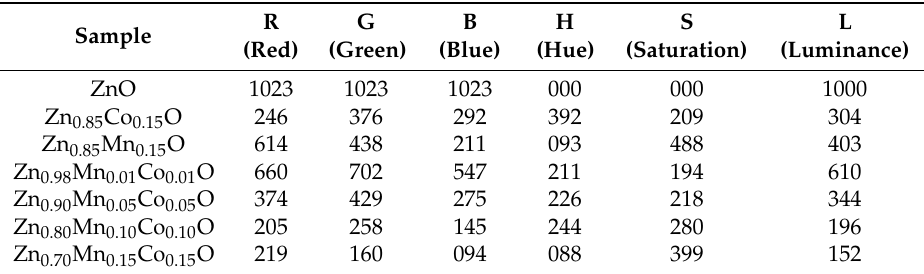
Table 7. Results of the colour analysis of dry NP samples (RGB and HSL colour model).